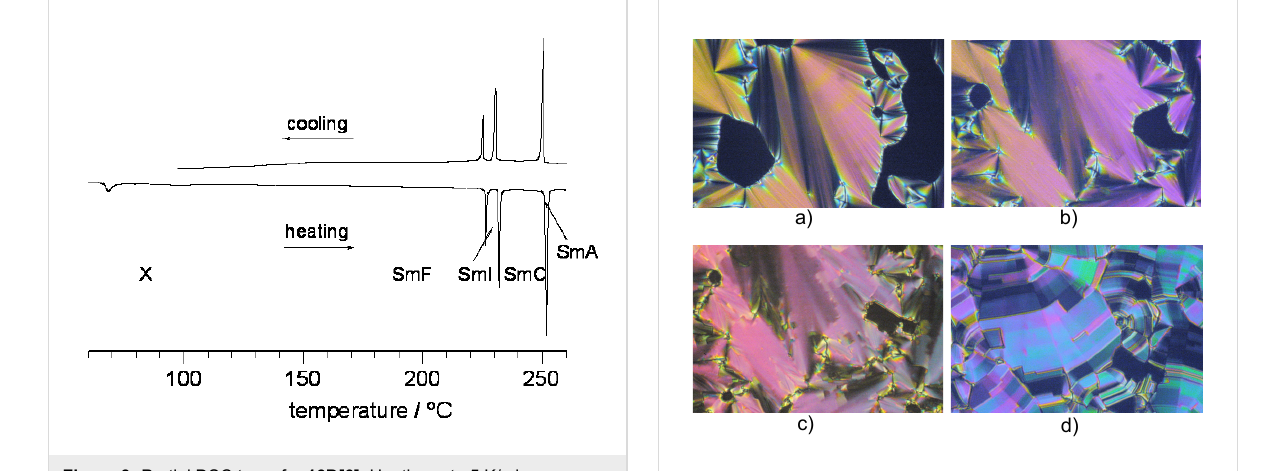
Figure 3: Partial DSC trace for 16D[6] . Heating rate 5 K/min.